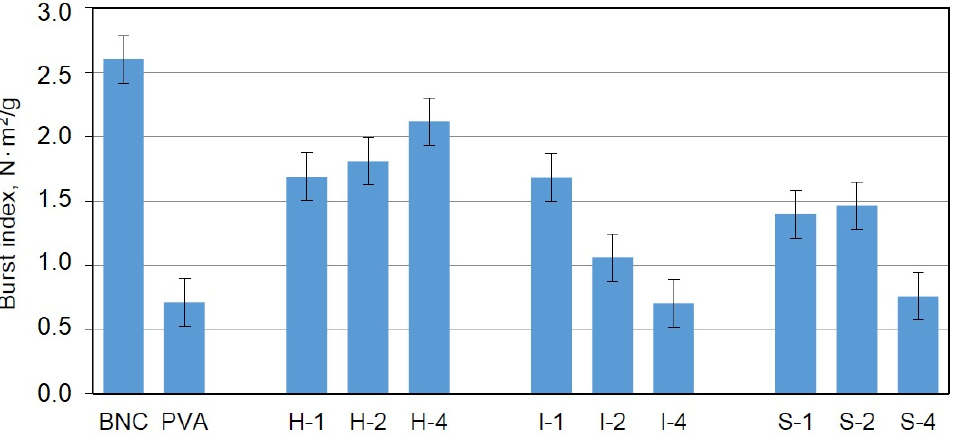
Figure 9. Burst index of dry samples of BNC, PVA, and BNC/PVA composites obtained by three methods.